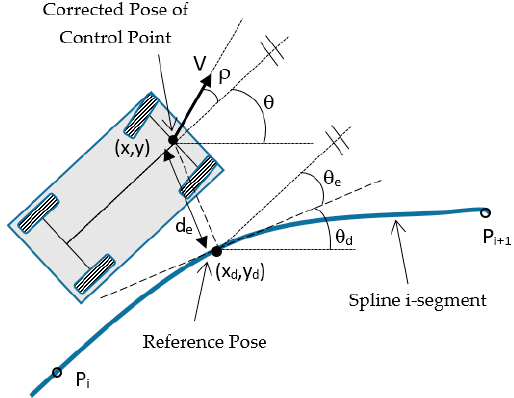
Figure 5. Variables involved in lateral control: reference pose χ d = ( x d , y d , θ d ) and tracking errors ξ = [ d e θ e ] (cid:48)